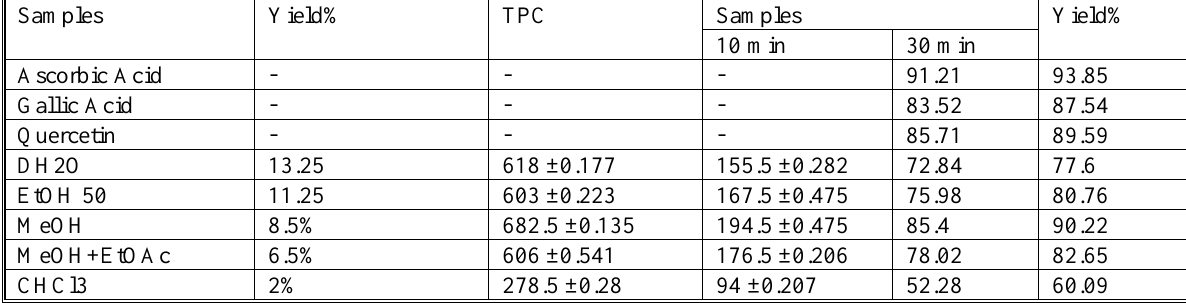
Table 5.TPC, TFC and RSA% of the standards and the extracts